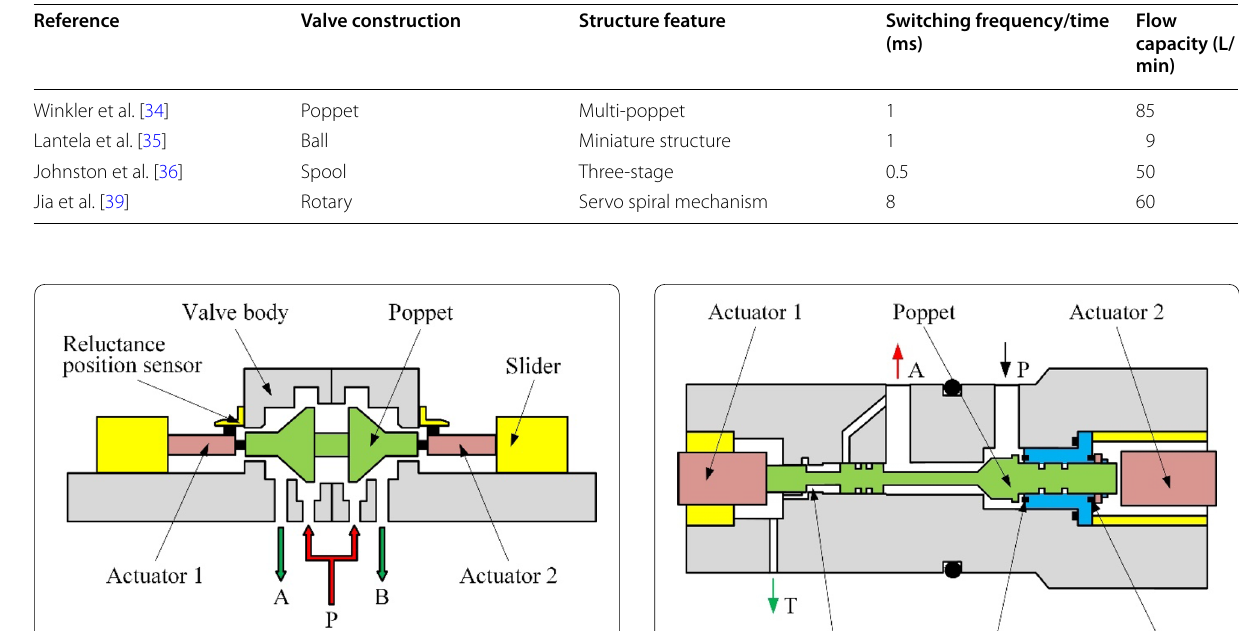
Figure 15 Poppet valve with two multilayered piezoelectric actuators developed by Yokota et al.